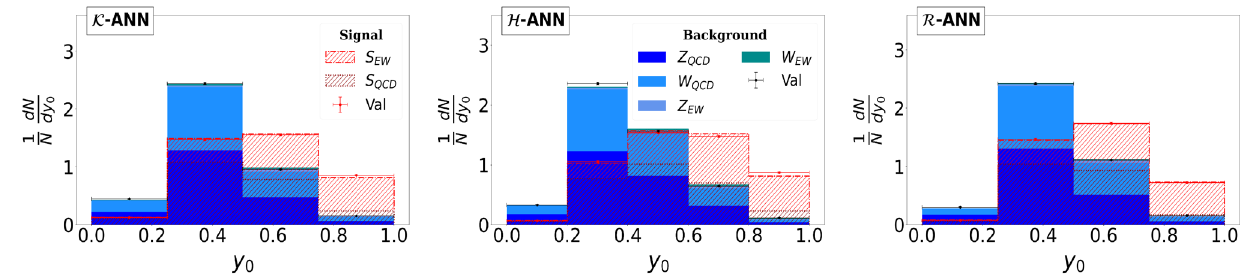
Fig. 12 Binned distribution of the network output for (left) K -ANN, (center) H -ANN, and (right) R -ANN